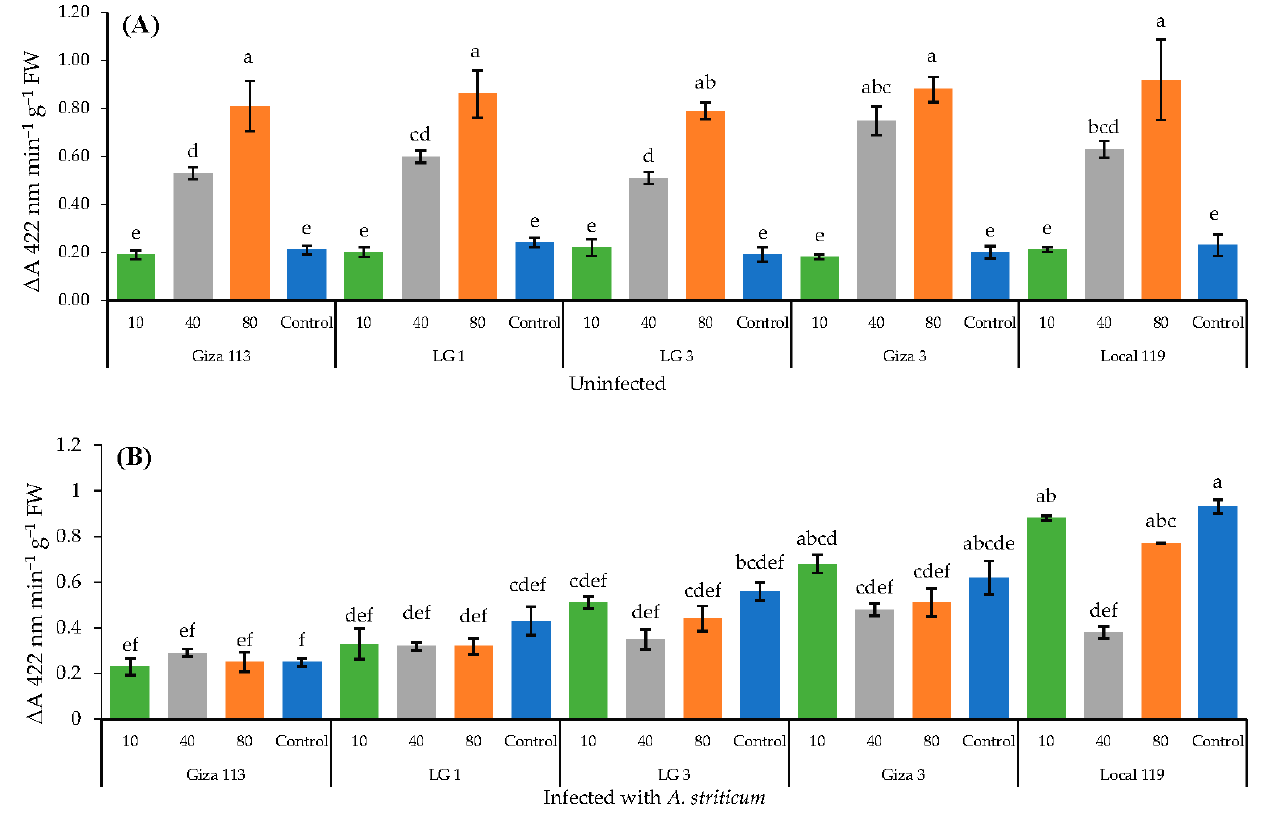
Figure 4. Activity of peroxidase in grain sorghum plants uninfected ( A ) and infected with A. striticum ( B ) in response to application of Fe 3 O 4 /HA NPs. Same letter in the figure means no significant differences between the values.